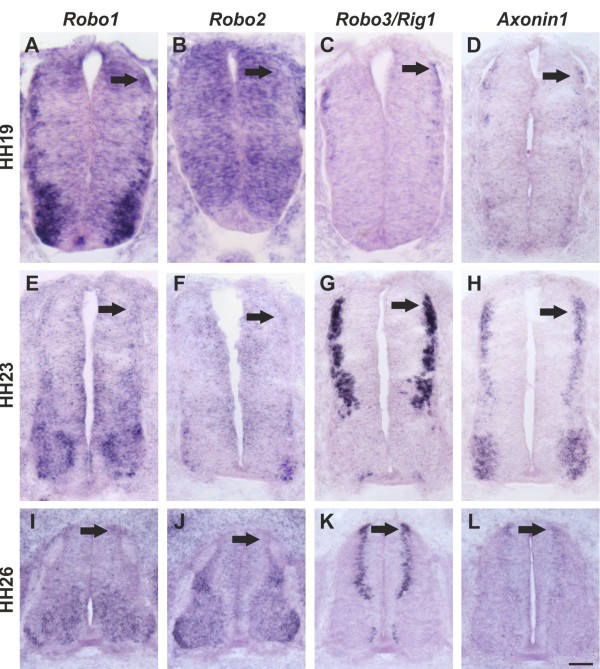
Commissural axons in the embryonic chicken spinal cord express all three Robos. We used in situ probes specific for Robo1 (A,E,I), Robo2 (B,F,J), and Robo3 (C,G,K) to assess their expression pattern in comparison to Axonin-1/TAG-1 (D,H,L) at HH19 (A-D), HH23 (E-H), and HH26 (I-L). Robo1 mRNA could be detected in commissural neurons as soon as they start to extend axons (arrow in A), and continued to be expressed in these neurons throughout the time window of their axonal navigation across the floor plate and into the longitudinal axis (arrows in E,I). Robo2 was expressed throughout the neural tube except for the floor plate at HH19 (B). Weak expression in a subset of commissural axons was found at HH23 (arrow in F). By HH26, Robo2 mRNA was barely detectable in dorsal commissural neurons (arrow in J). At all stages, Robo3 mRNA was found in dorsolateral commissural neurons (arrows in C,G,K). Axonin-1/TAG-1 expression indicates the position of dorsal commissural neurons (D,H,L). Bars: 33 μm in A-D, 50 μm in E-H, 100 μm in I-L. Dorsal is to the top in all panels.